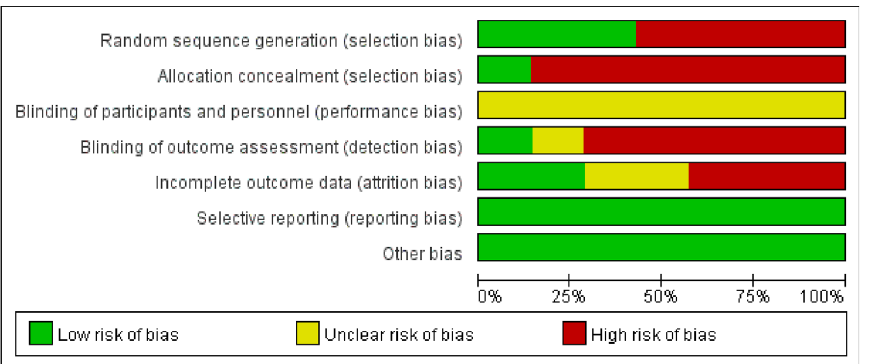
Figure 4. Risk of bias summary: review authors’ judgments about each risk of bias item for each included study.